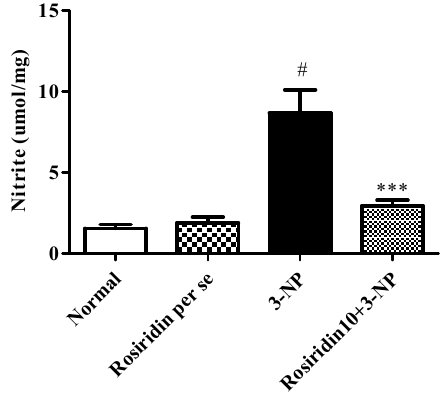
Figure 10. Effect of rosiridin on nitrite content. Values are expressed as the mean ± SEM (n = 6). Values are statistically significant at p < 0.05 (one-way ANOVA followed by Dunnett’s test). Express the data ( # p < 0.05) saline vs. negative control group; (*** p < 0.001) negative control group vs. treatment group.